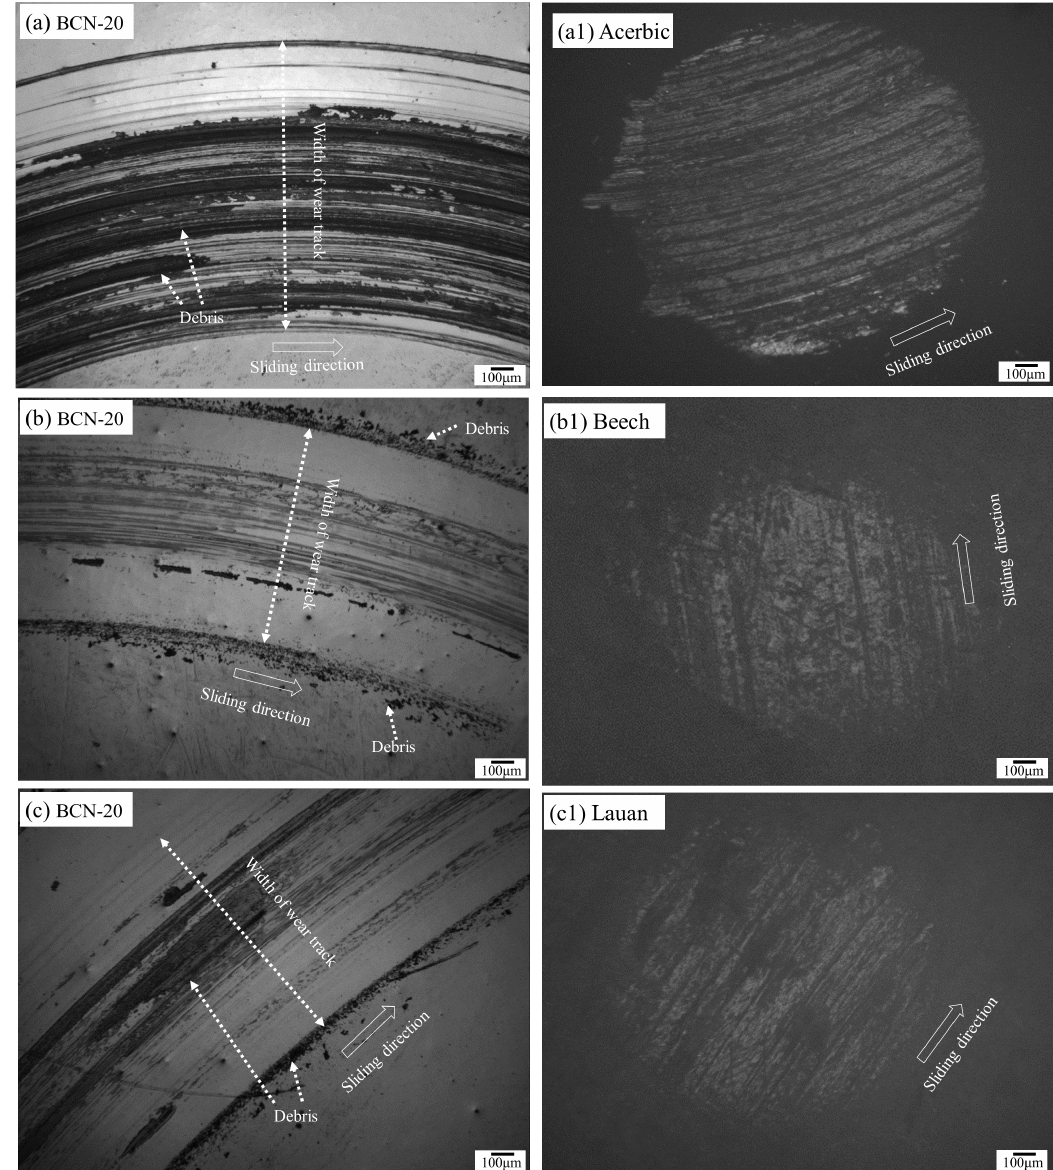
Figure 9: Optical images of wear scars for BCN-20 coating sliding against different wood